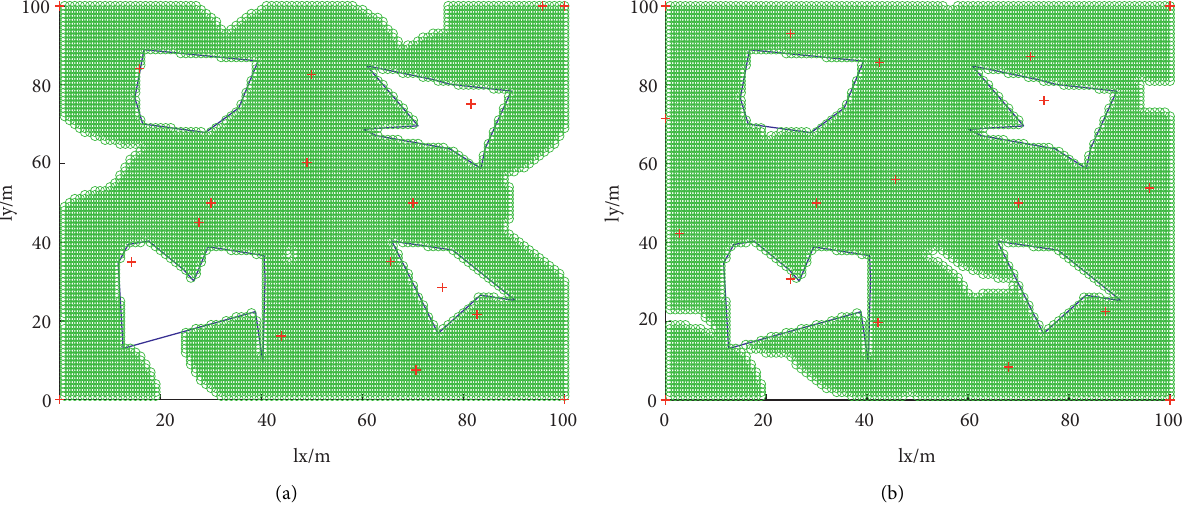
Figure 14: Network coverage of 12 nodes: (a) before optimization and (b) after